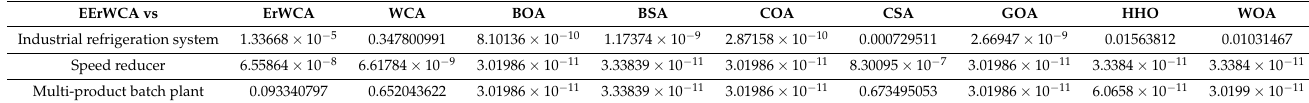
Table 11. Statistical results of EErWCA versus other metaheuristics on engineering